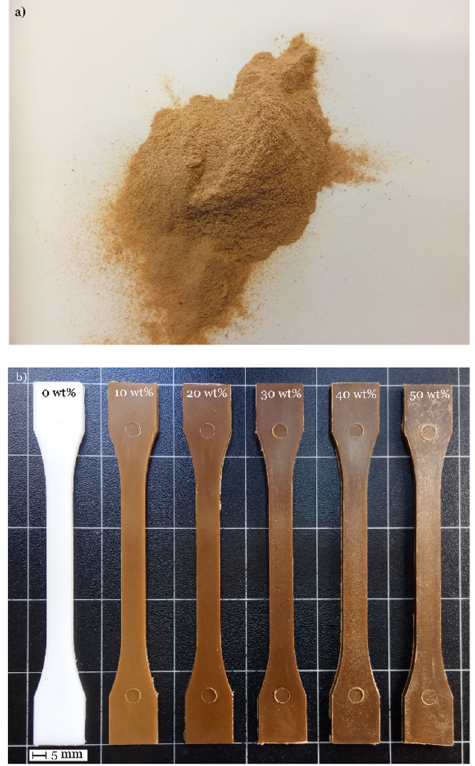
Figure 1. ( a ) Powdered almond shell flour (ASF) and ( b ) injection moulded PBS/ASF/MLO composites with varying ASF content in wt %.